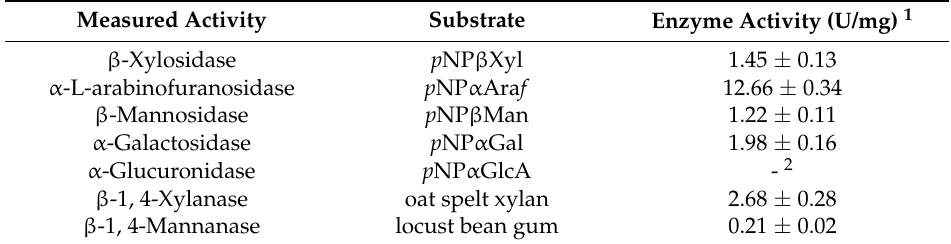
Hemicellulytic activities of the enzyme extract of Paenibacillus polymyxa KF-1 on different